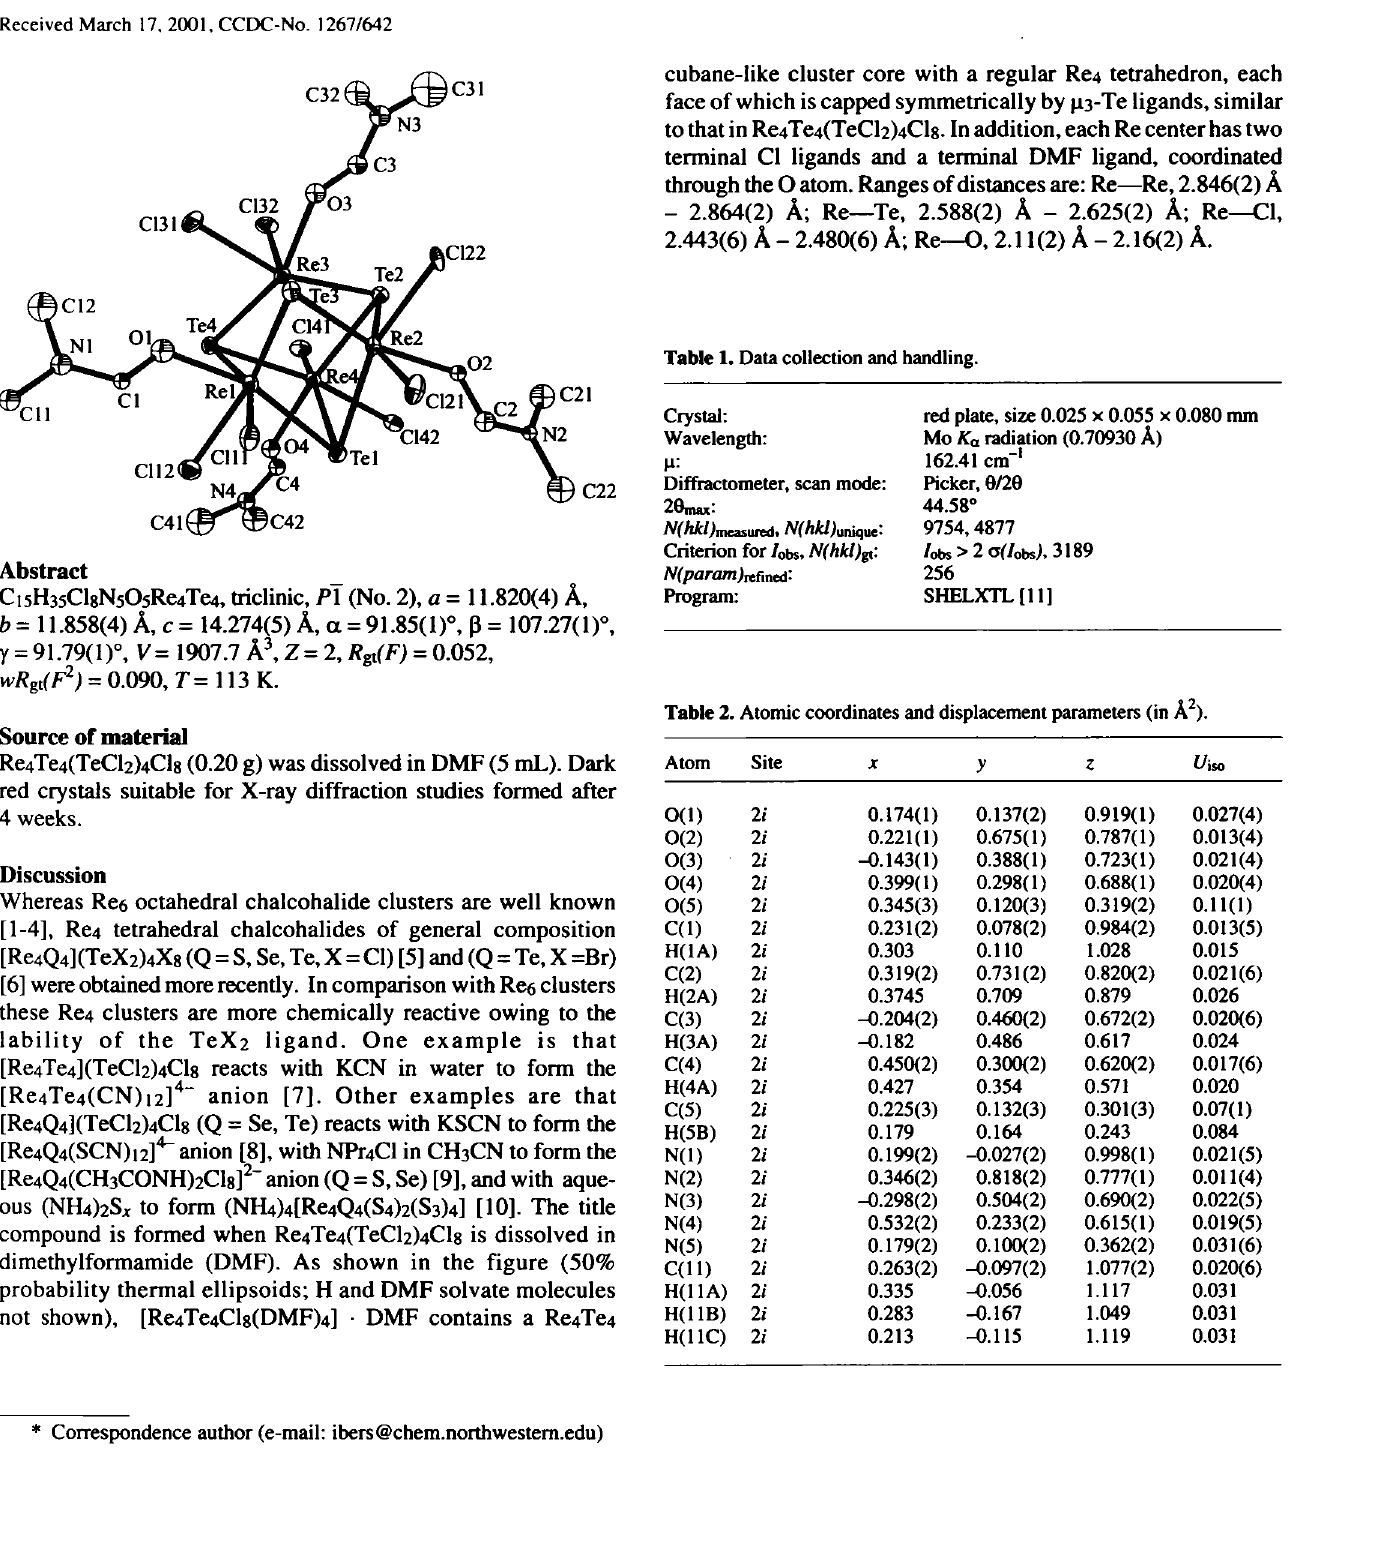
Table 1. Data collection and handling.